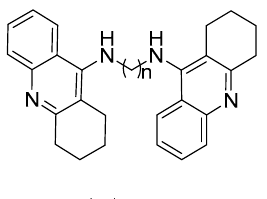
Figure 21. Bis tacrine homodimers.